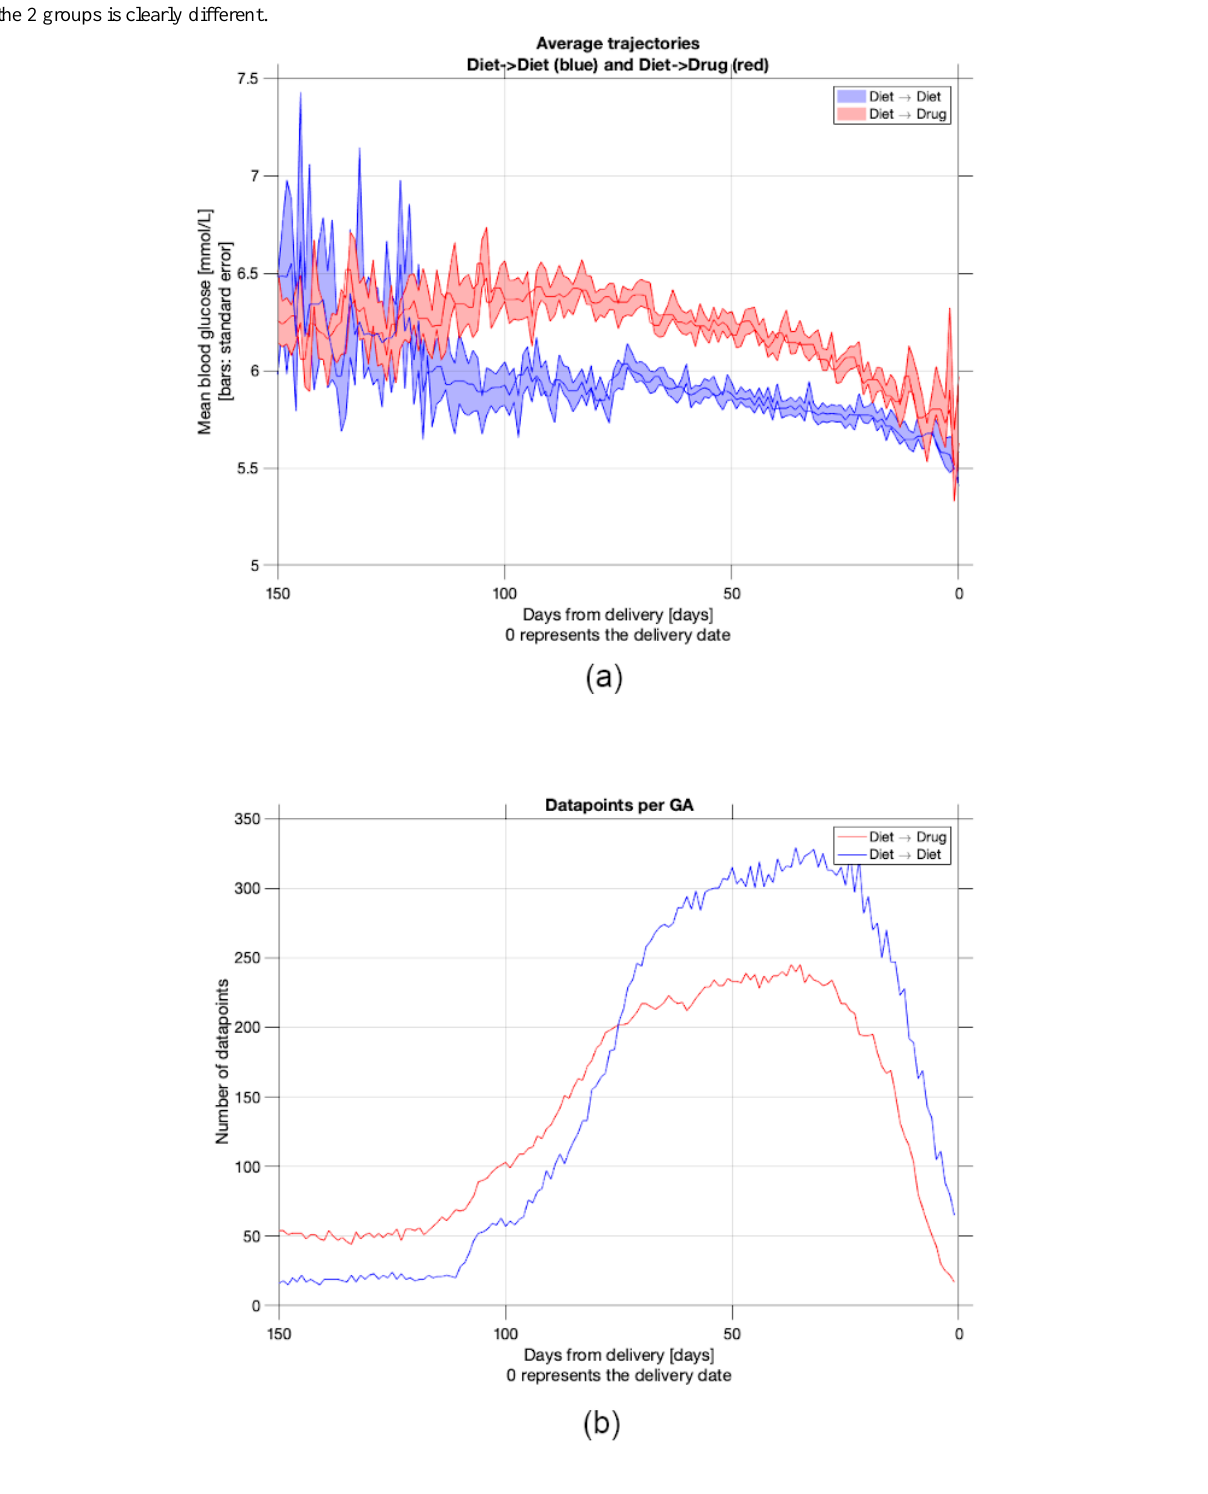
Figure 3. Graph (a) shows the average and SE of blood glucose values per day corresponding to the 2 groups. Graph (b) indicates how many readings per day were used to obtain the average in (a). In both cases, the number of days on the x-axis refers to the number of days to delivery. For the period where the number of readings is high, 100 to 5 days to delivery, which roughly corresponds to the last 3 months, the average of the blood glucose values for the 2 groups is clearly